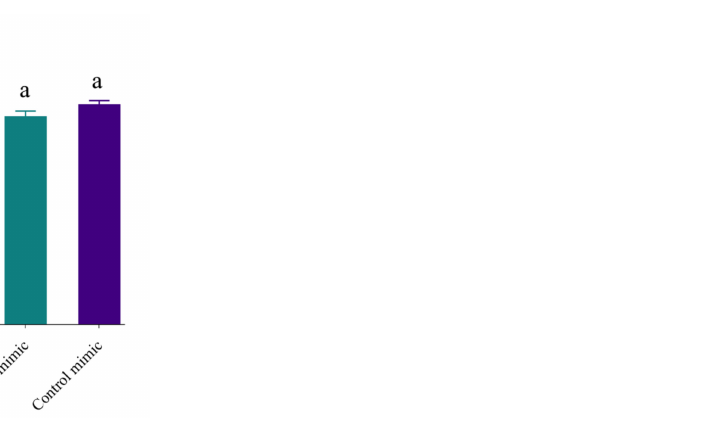
Figure 6. Trypsin enzyme activity in gut extracts from larvae fed on miR-11912-5p-mimic, control mimic, control, and PBS (no gut content). Three technical and two biological replicates per treatment were analyzed. Letters indicate significant differences at p < 0.001.